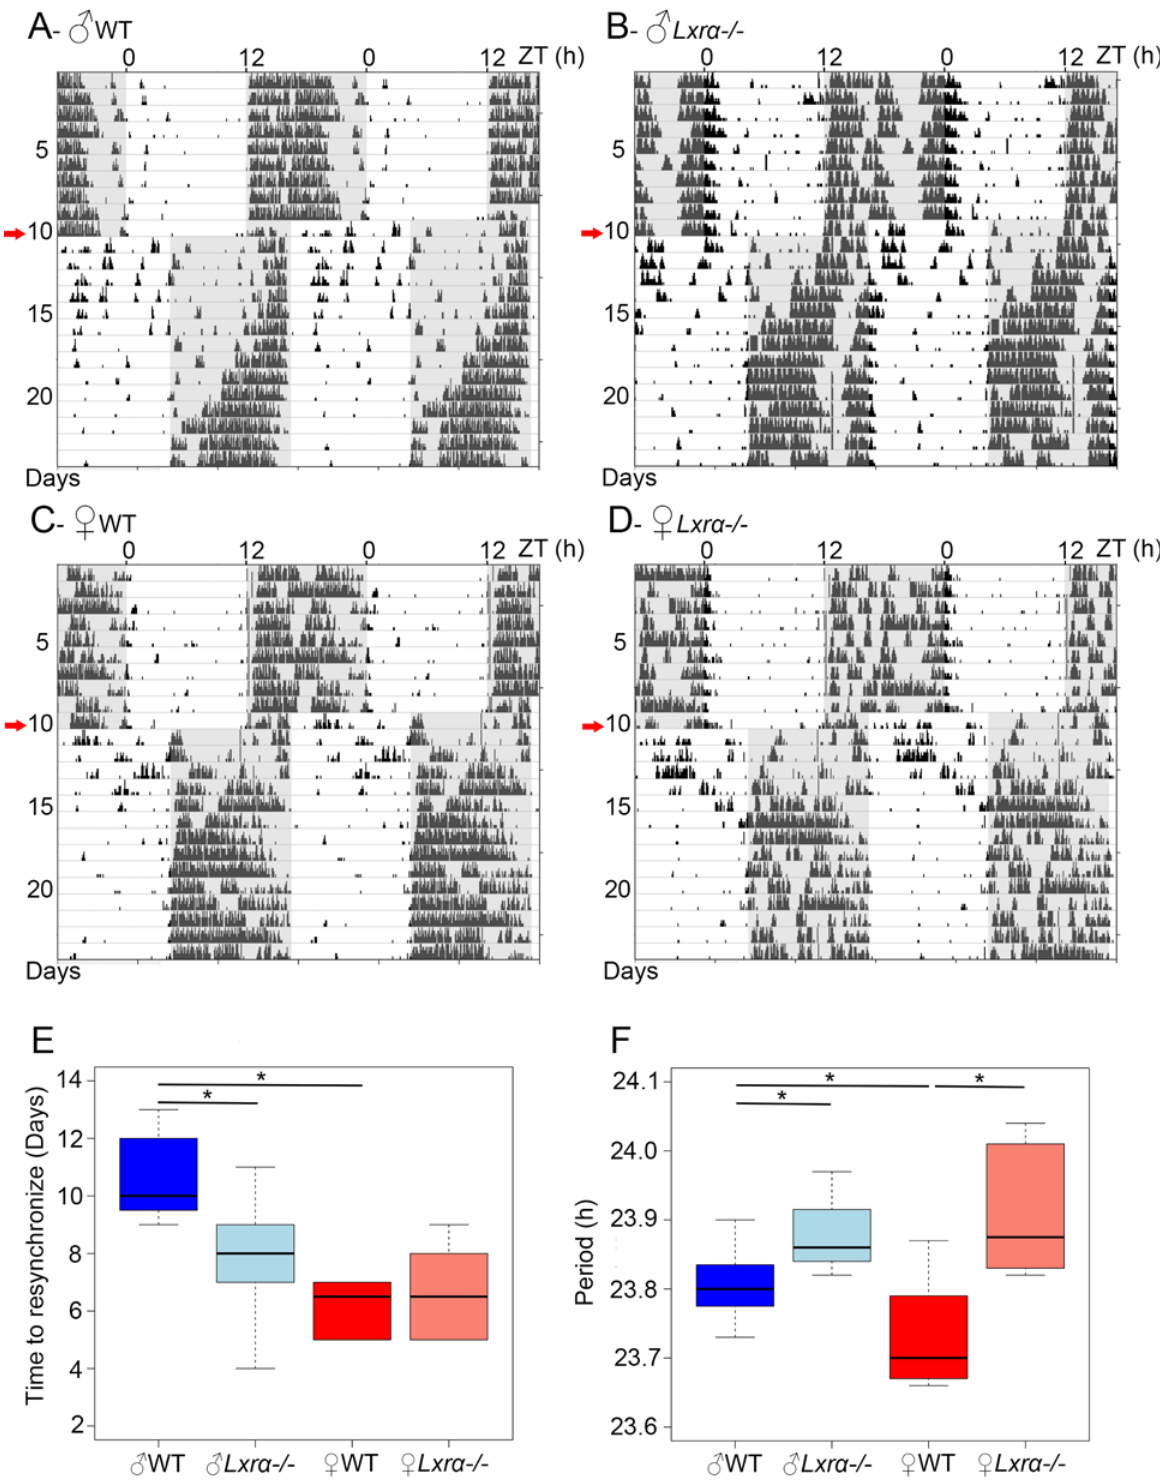
Fig 2. Resetting after jetlag differs between male and female in wild type but not in Lxr α -/- mice. Wheel running activity was measured in animals entrained to a LD12:12 and then submitted to an 8-hours jetlag (red arrow). Representative actograms for male (A) and female (B) wild type mice and male (C) and female (D) Lxr α -/- mice are shown. In A-D, the white and grey bars represent the light and dark phases respectively. Box and whiskers plots for